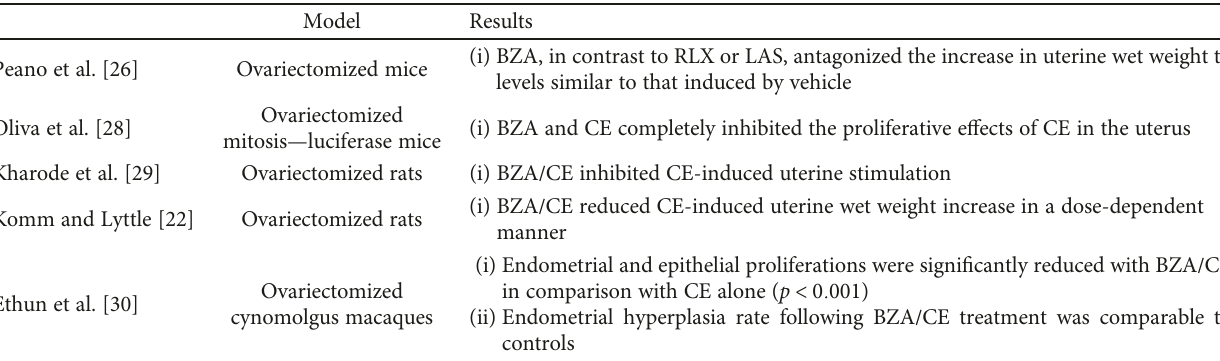
Table 3: Preclinical studies on endometrial